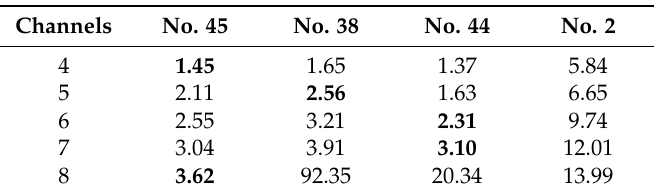
Table 4. Comparison of the condition numbers of the best-performed filter set (No. 45, 38 and 44) and the traditional suboptimal selection (No.